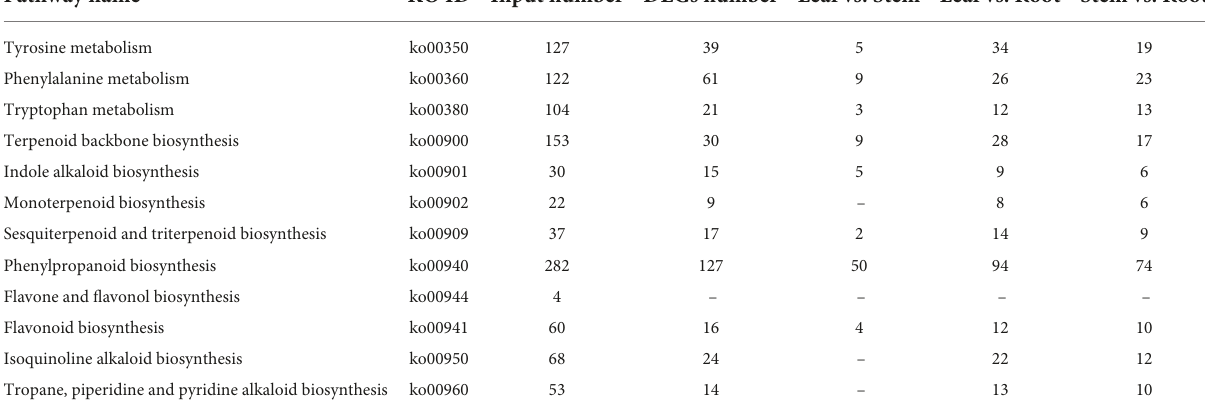
TABLE 3 Pathways involved in biosynthesis of iridoid glycosides, flavonoids and phenylethanol glycosides. Pathway